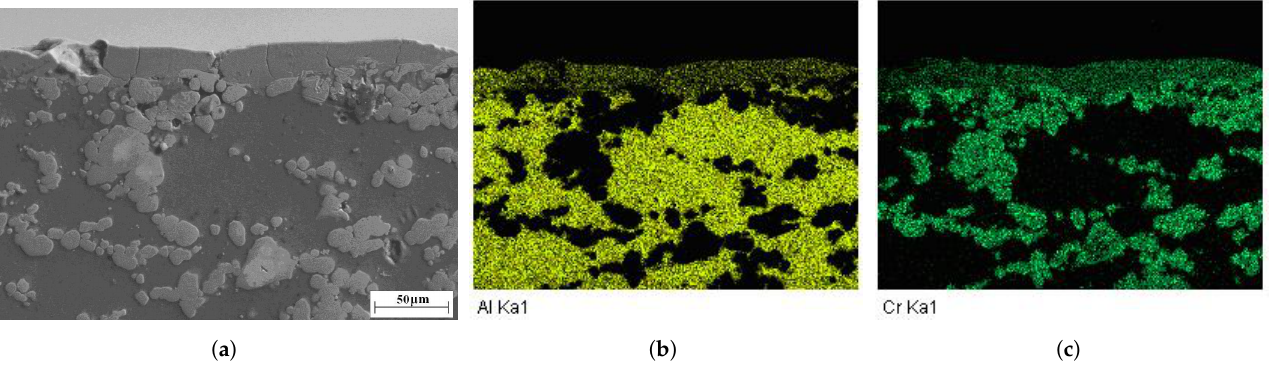
Figure 6. EDS element (Al ( b ) and Cr ( c ) elements) mapping in the near-surface region ( a ) of the Al 0.7 Cr 0.3 cathode according to the results of the EDS